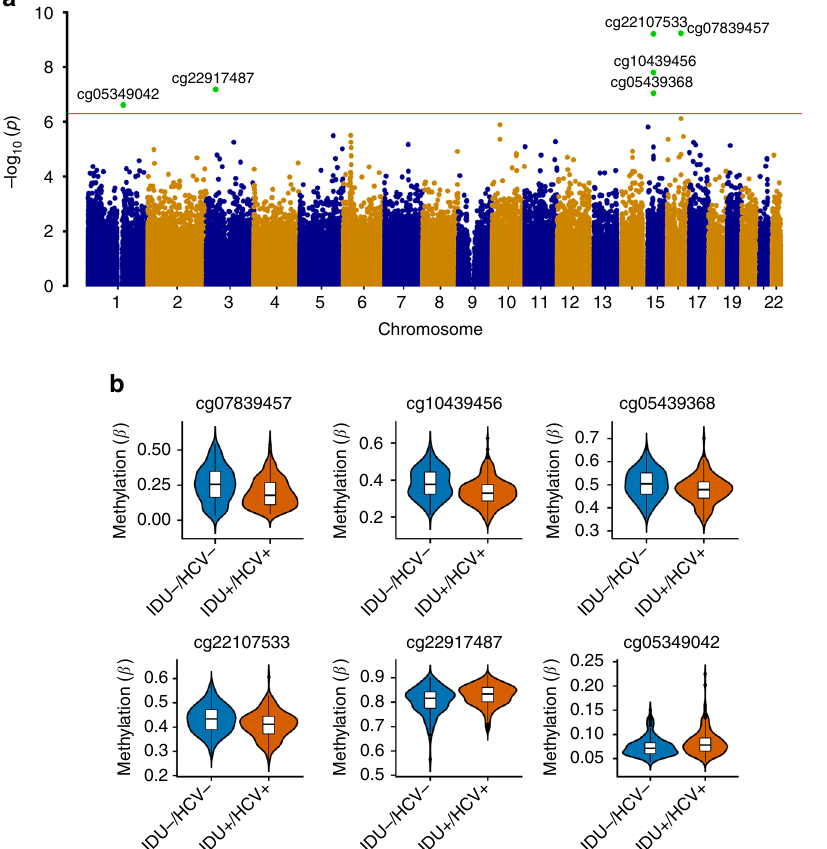
Fig. 1 Epigenome-wide association analysis identi fi es six signi fi cant CpG sites for injection of illicit drug use comorbid with hepatitis C in HIV-infected individuals. a Manhattan plot of chromosomal locations of − log10( p values) for association in 437,722 CpG sites among 386 HIV-infected African American men with and without injection of illicit drugs comorbid with hepatitis C infection in the discovery sample set. The red line presents the threshold for nominal p = 5E10-07. b Violin plot showing differential DNA methylation of six signi fi cant CpG sites between subjects comorbid for injection drug use and hepatitis C (IDU+/HCV+) compared to non-injection drug use and non-hepatitis C (IDU − /HCV − ) subjects in the discovery sample. Methylation ( β ) is on a scale 0 – 1. The line in the middle shows average methylation in each group. Four CpG sites (cg07839457, cg10439456, cg0539368, cg22107533,) were hypomethylated and two CpG sites (cg22917487 and cg05349042) were hypermethylated in IDU+/HCV+ compared to IDU − /HCV